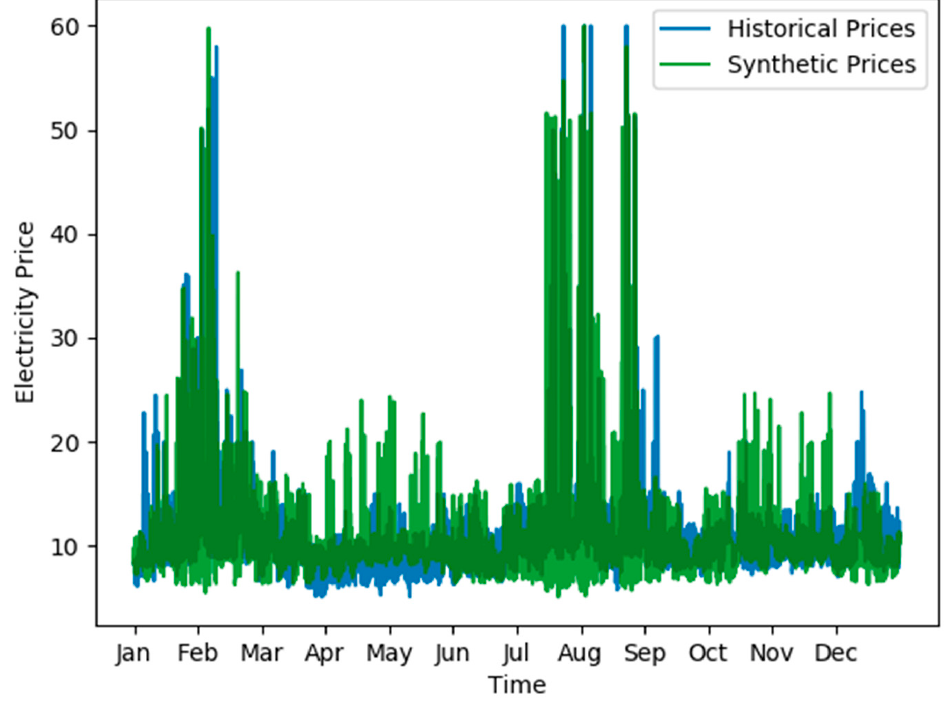
Figure 4. Historical 2018 Tokyo region electricity prices plotted against the synthetic time history produced by sampling the RAVEN FARMA.